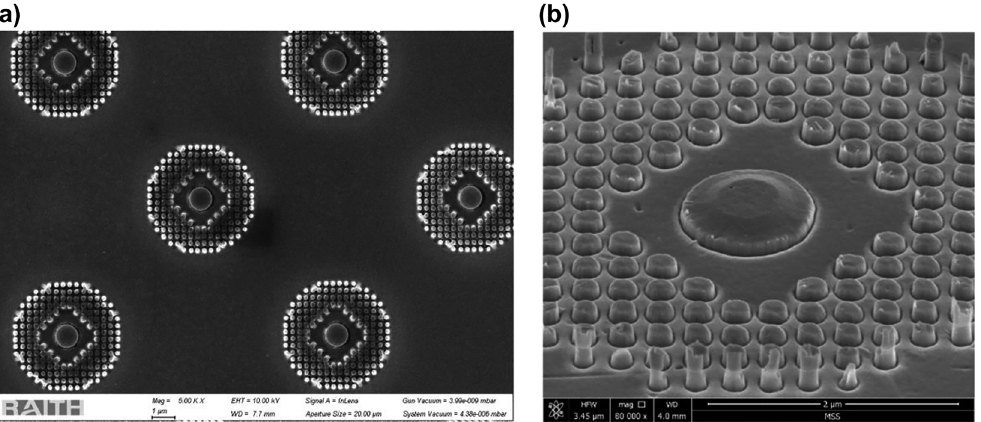
Figure 3: SEM images of the color-routing axicon metalens. (a) Front view, scale bar = 1 μ m. (b) Glancing angle view, scale bar = 2 μ m. The top layer patterns are on a silica substrate with a thickness of 500 μ m. TiO 2